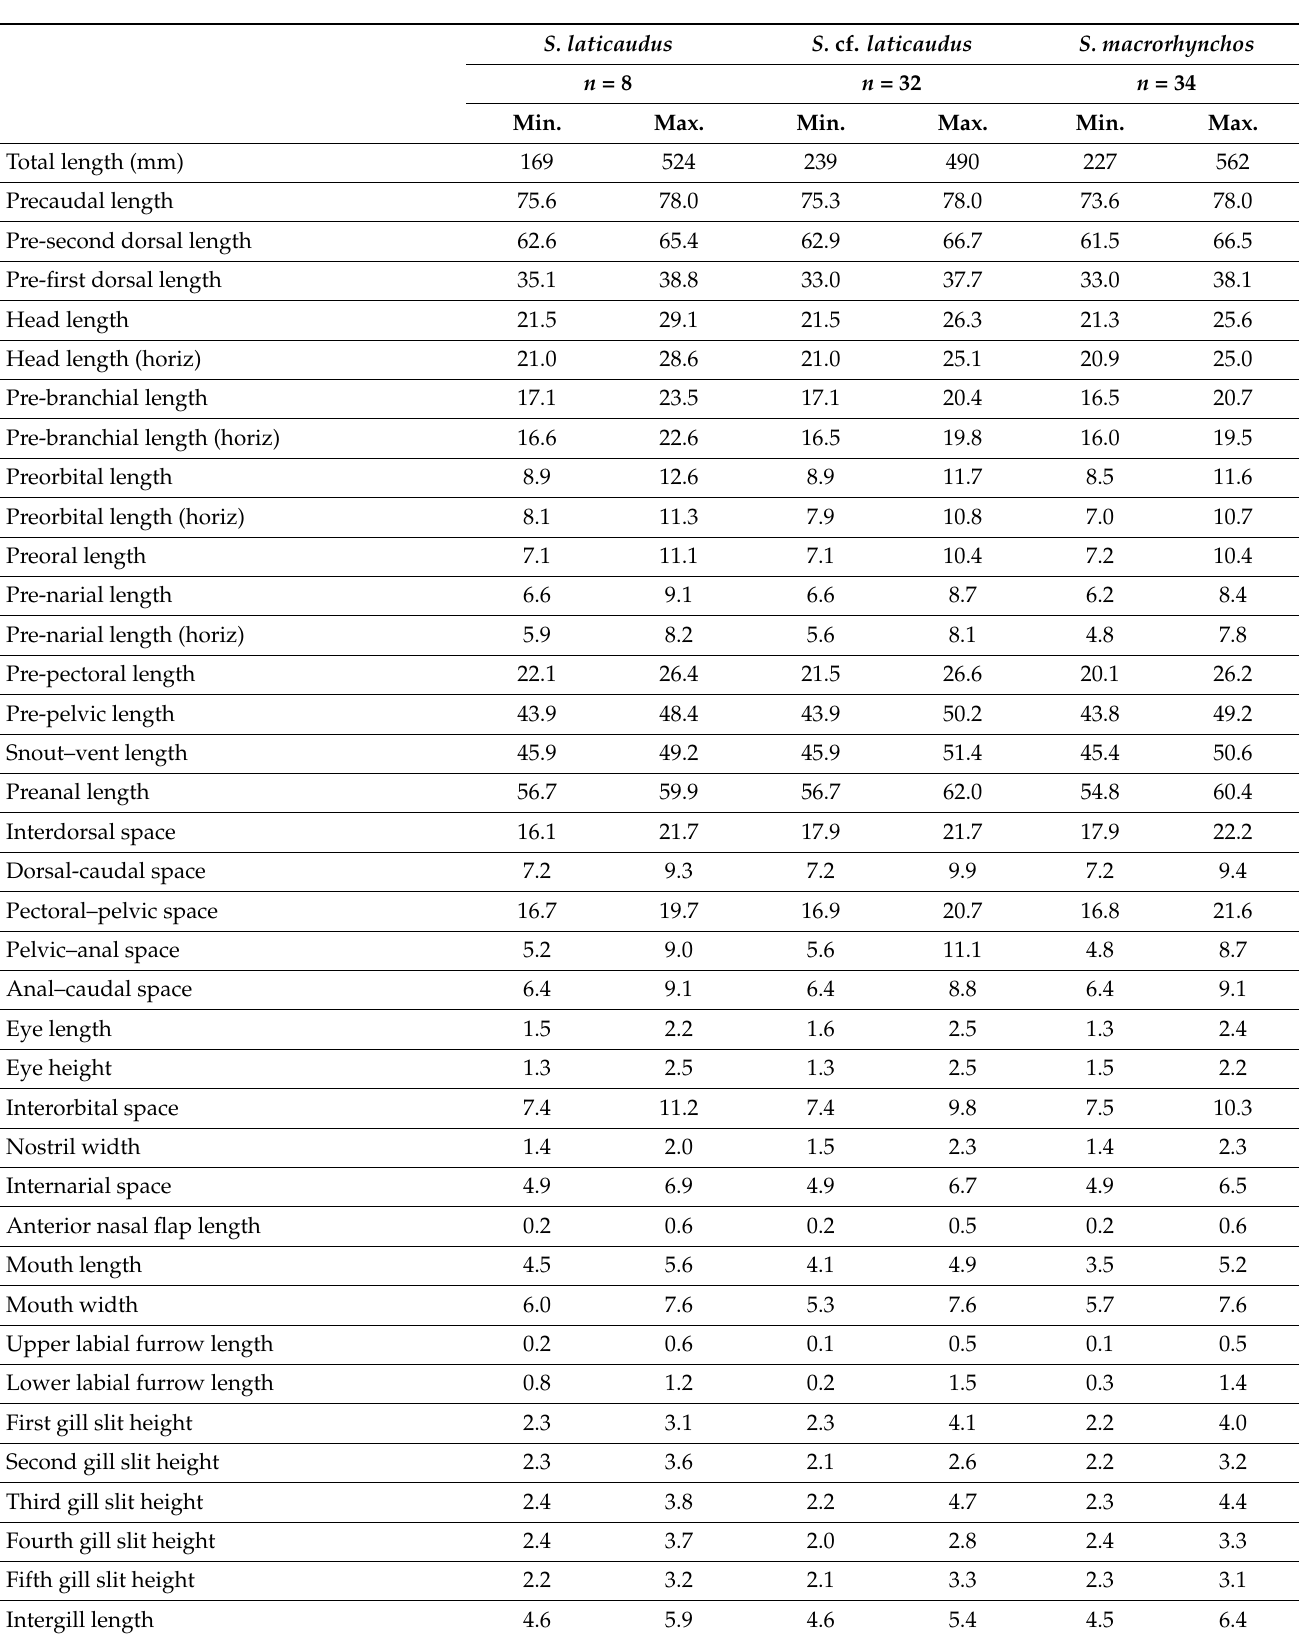
Table 2. Ranges of proportional dimensions as percentages of the total length for the three ‘species’ of Scoliodon